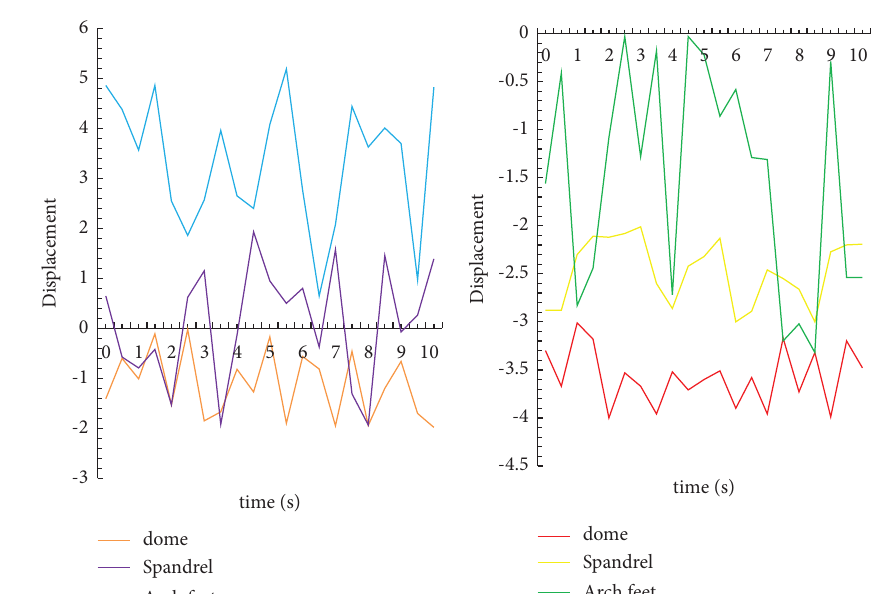
Figure 7: Displacement time-history curve of each observation point of the conventional and interchange sections of the upper-span